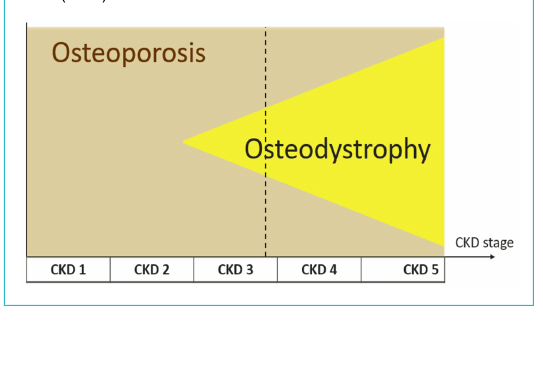
Figure 5: Osteoporosis and osteodystrophy in chronic kidney dis- ease